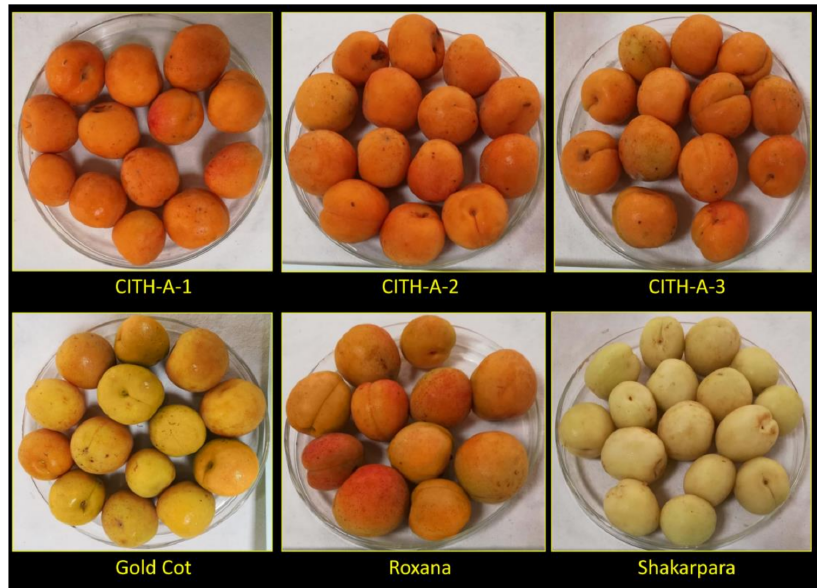
Figure 1. Variation in skin colour of different apricot